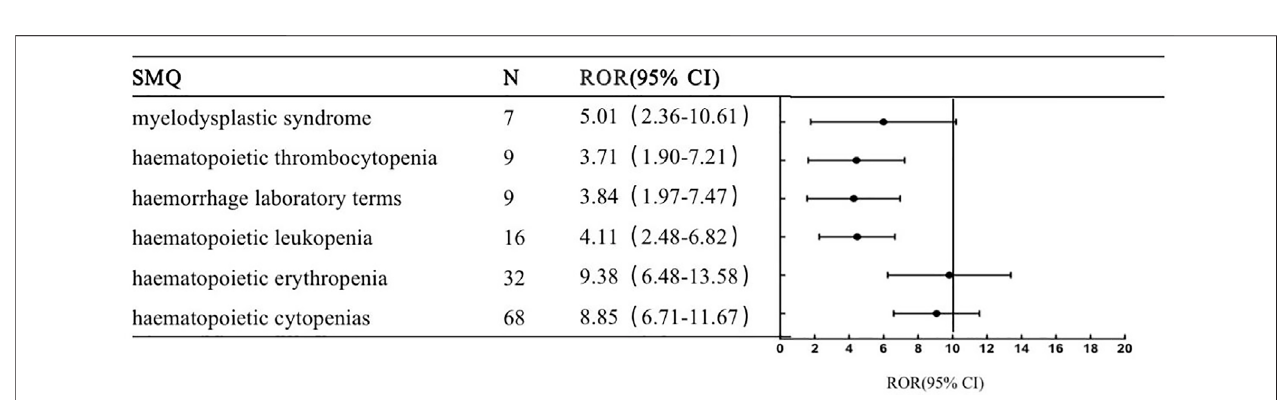
FIGURE 4 | The positive signal distribution of Talazoparib using standardized MedDRA queriesable.